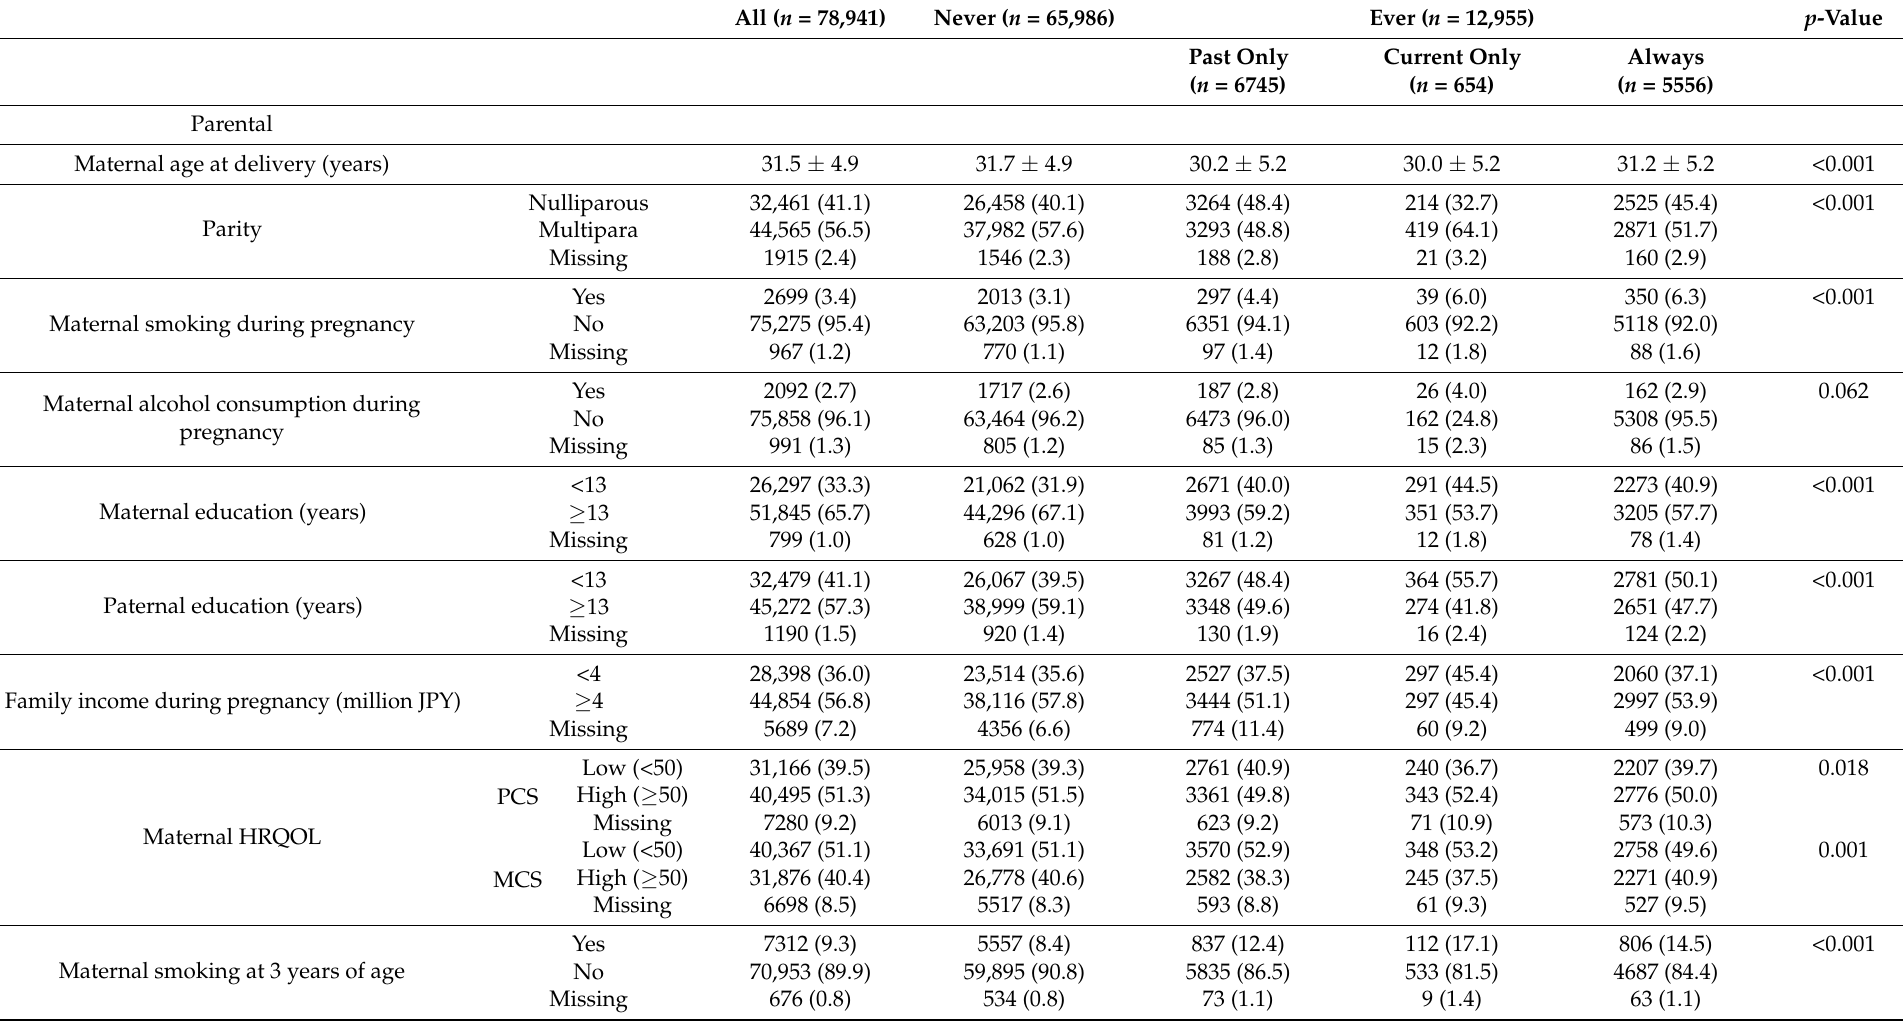
Table 1. Characteristics of participants sorted by family dog ownership